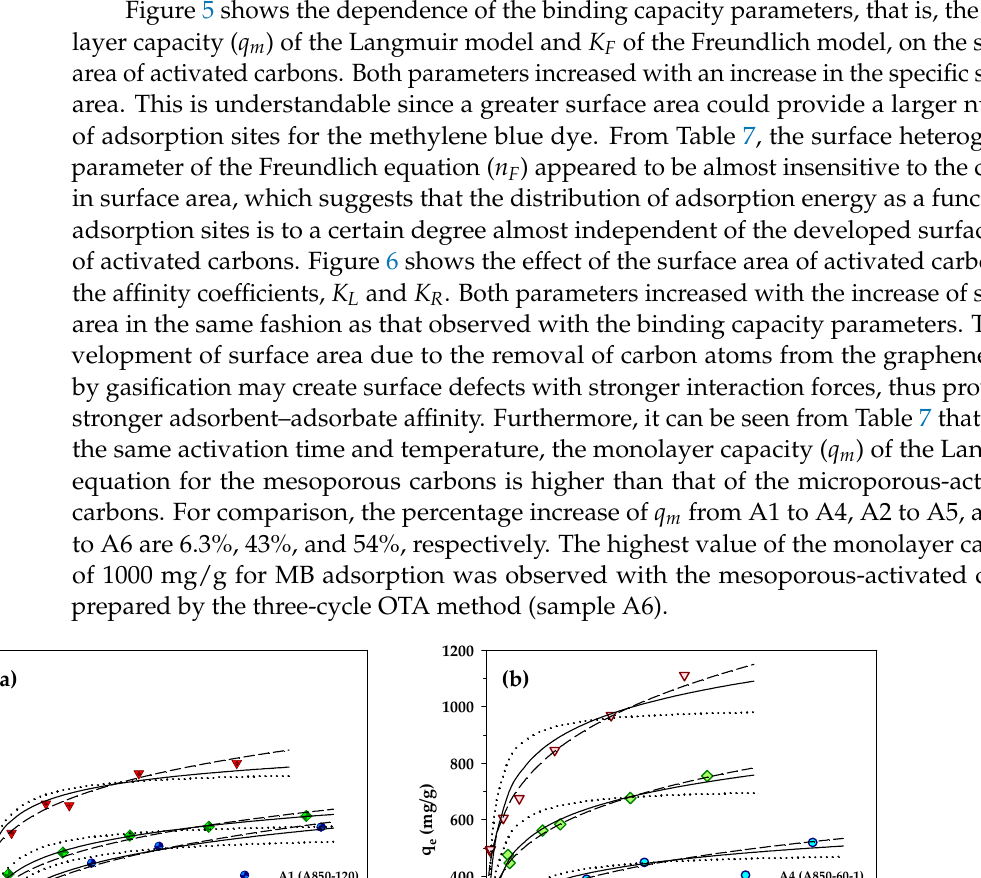
Figure 5. Effect of BET surface area on monolayer capacity ( q m ) of the Langmuir isotherm equation and K F of the Freundlich equation.